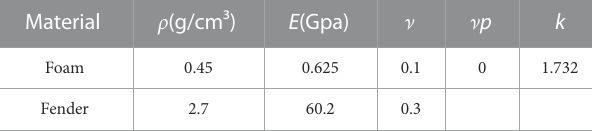
TABLE 1 The materials ’ parameters (Deshpande and Fleck,